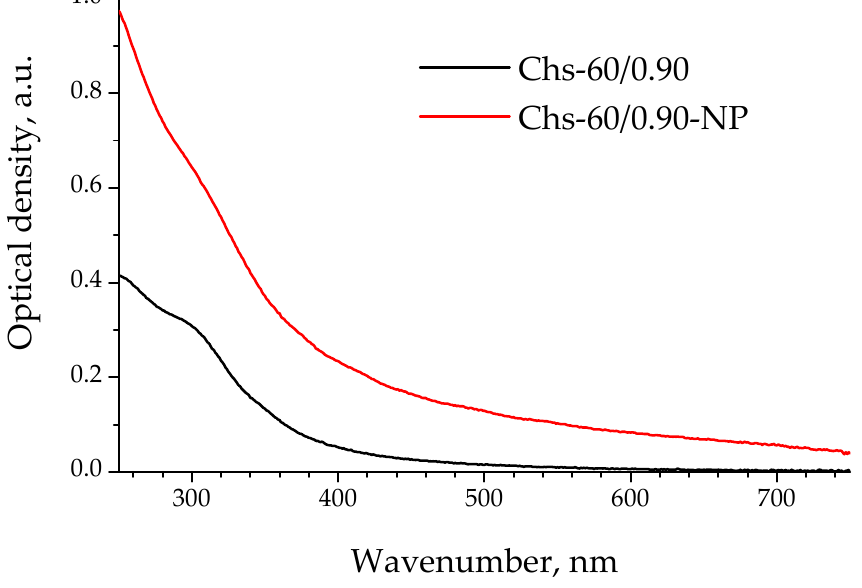
Figure 3. Electron absorption spectra of 0.5 wt.% chitosan Chs-60/0.90 solution in 2%CH 3 COOH in and nanoparticles Chs-60/0.90-NP fabricated by chitosan precipitation. and nanoparticles Chs-60/0.90-NP fabricated by chitosan